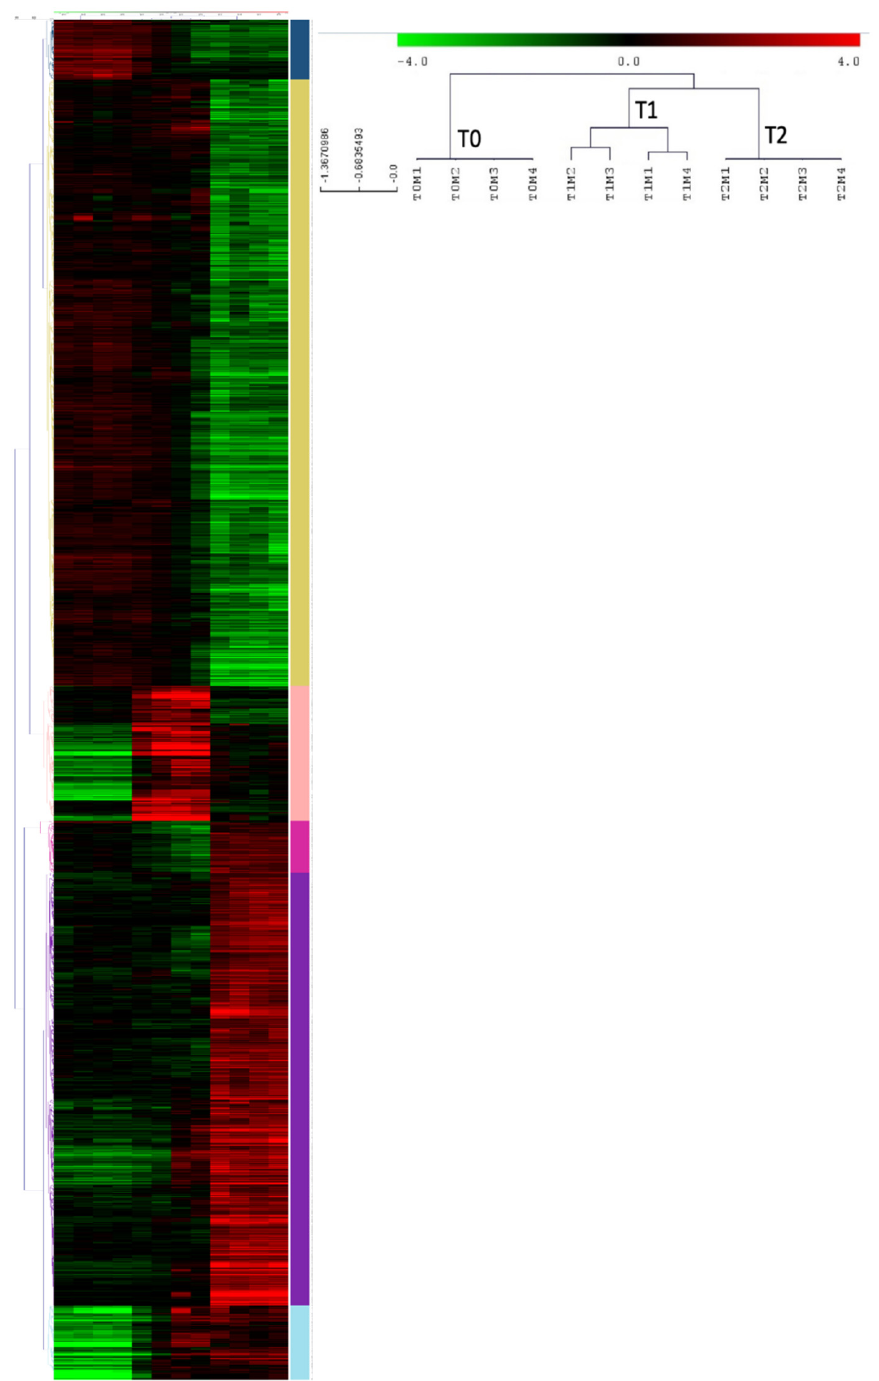
Figure 2. Unsupervised hierarchical clustering of probes in our mouse sepsis model. The samples in each column (vertical) and the probes in each row (horizontal) were (re)arranged. Six vertical clusters (blue, yellow, light pink, fuchsia, purple, and light blue) and 3 horizontal clusters were obtained corresponding to genes of similar expression pattern placed close to each other, and samples with comparable traits (T0, T1, and T2), respectively. The heatmap indicates upregulation (red), downregulation (green), and mean gene expression (black).